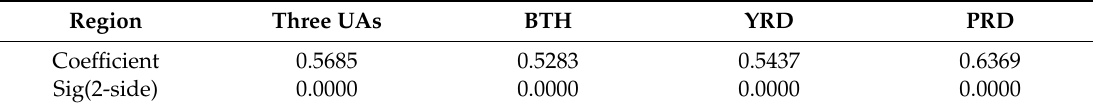
Table 8. The Pearson coe ffi cient between intercity-MAI and intercity population